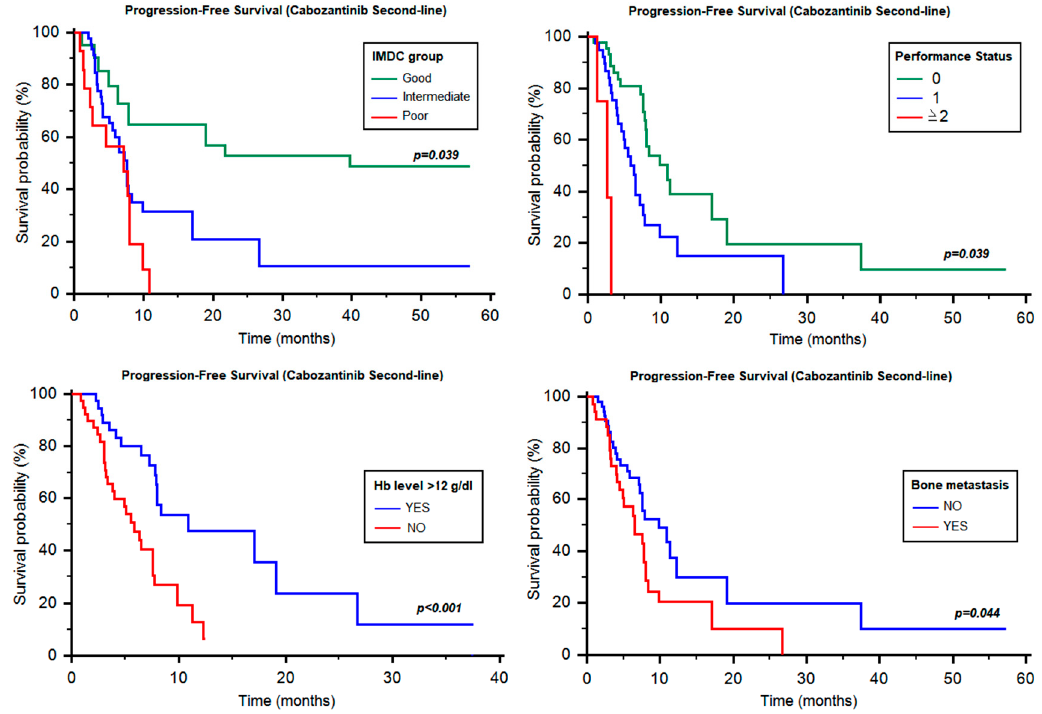
Figure 1. Progression-free survival of second-line cabozantinib according to di ff erent prognostic factors. Hb = hemoglobin; IMDC = International Metastatic Renal Cell Carcinoma Database